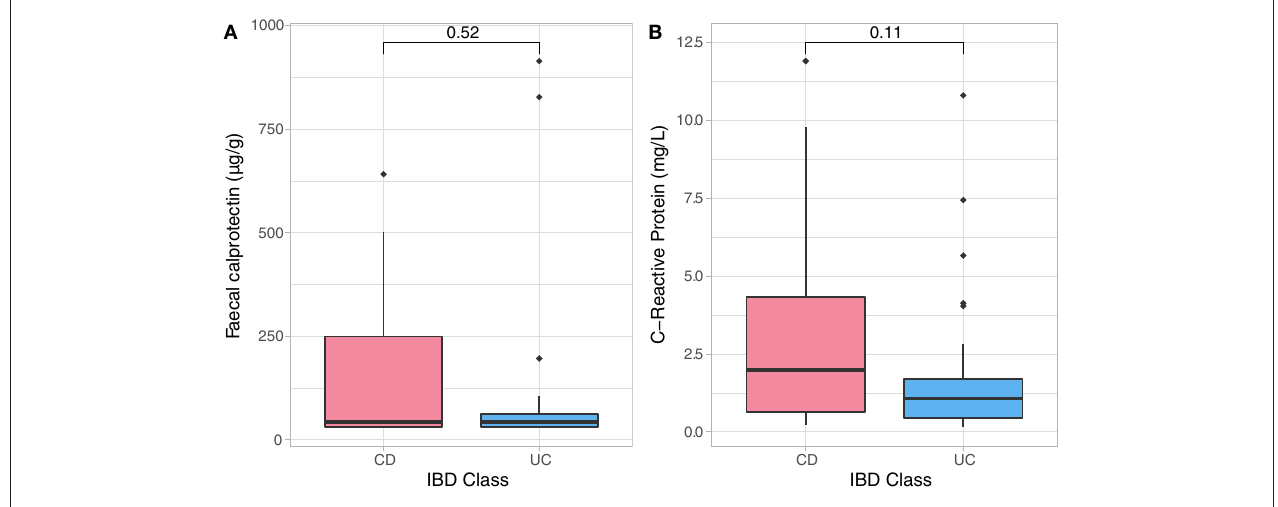
FIGURE 1 | Non-parametric analysis quantifying F-calprotectin (A) and C-reactive protein (CRP) (B) at baseline and across diagnosis. Analysis did not show significant differences in measures of both CRP and FC in CD and UC participants at baseline